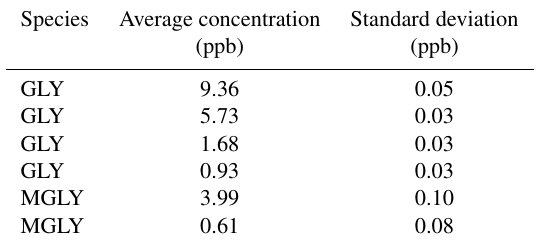
Table 1. Measurements of gaseous GLY and MGLY prepared by our standard gas generator and supplied for